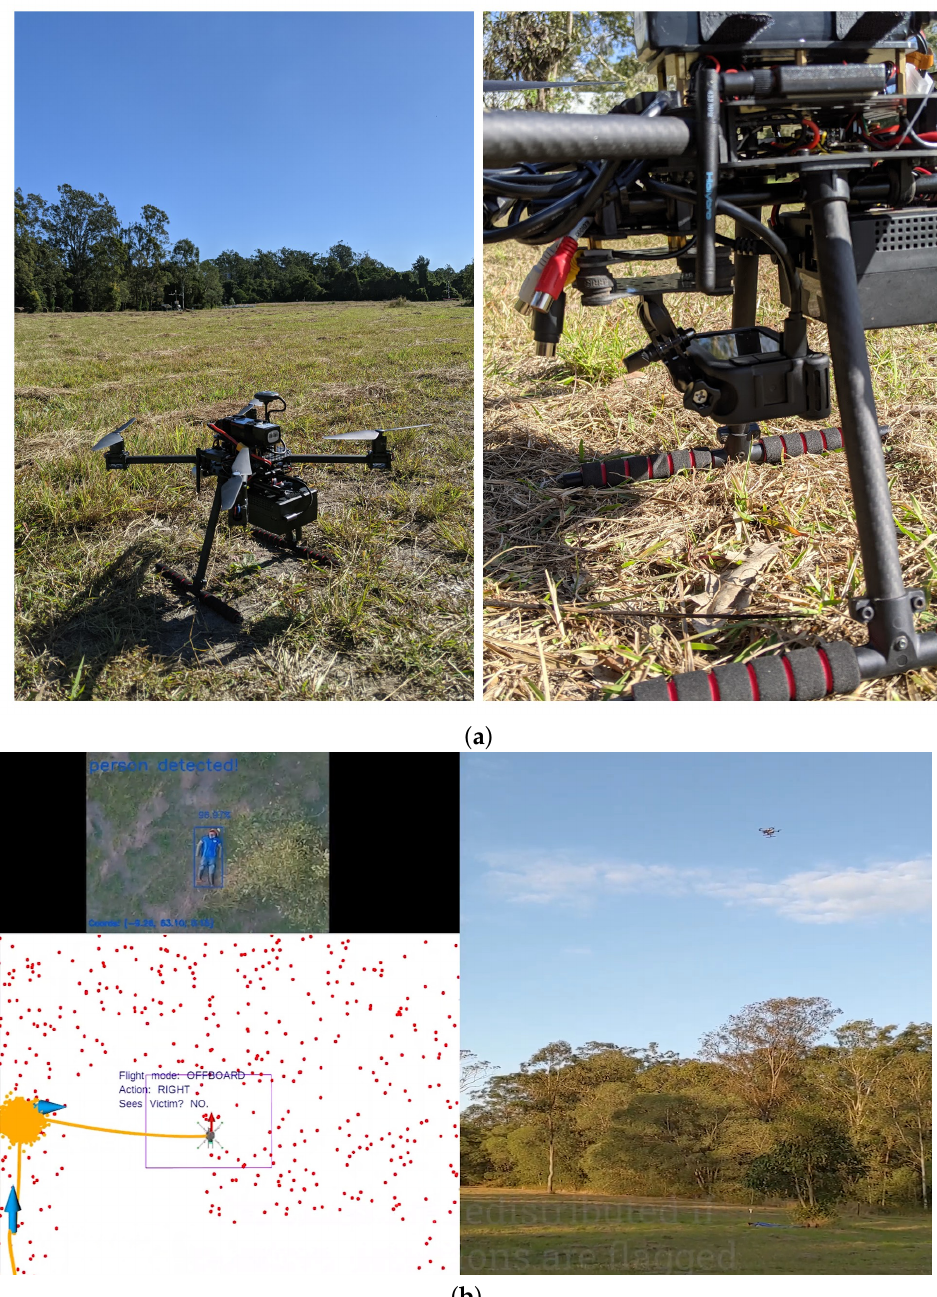
Figure 19. Demonstration of the presented UAV system in hardware with real flight tests at QUT SERF. ( a ) Holybro X500 quadrotor UAV frame kit with UP 2 as a companion computer and a GoPro Hero 9 as RGB camera. ( b ) UAV detecting an adult mannequin for the first time while navigating in offboard flight